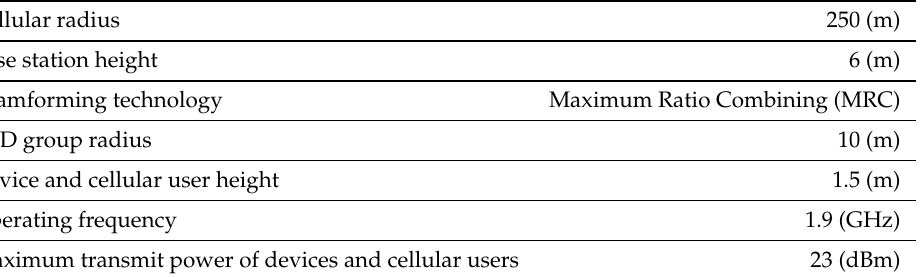
Table 1. Simulated network parameters.